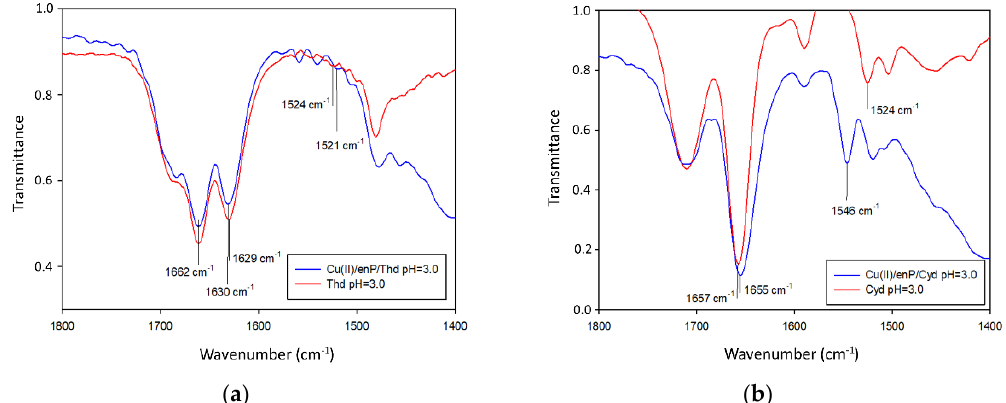
Figure 4. IR spectra of ( a ) Cu(enP)H 3 (Thd) and ( b ) Cu(enP)H 3 (Cyd) complexes compared to the free ligands.